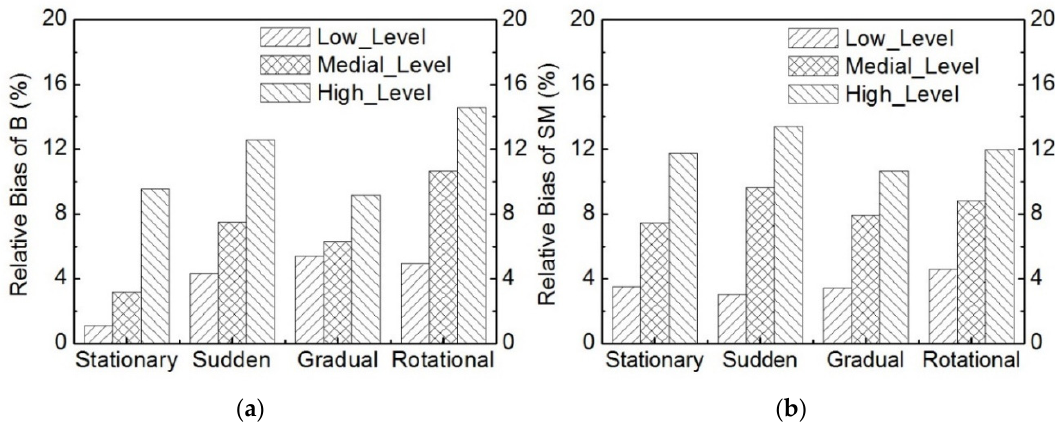
Figure 4. Relative bias of parameter B ( a ) and SM ( b ) estimation under different levels of uncertainties as shown in Table 2.